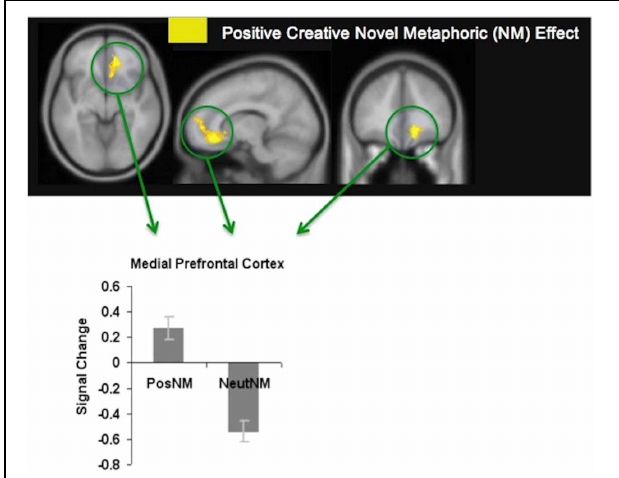
FIGURE 4 | Positive creative novel metaphoric effect. Signal change for positively-valenced creative novel metaphors (PosNM) vs. neutral novel metaphors (NeutNM) at a threshold of p < 0 . 001 (uncorrected). Mean mPFC signal (beta weights) for each condition is revealed in the bar chart [adapted from Subramaniam et al.